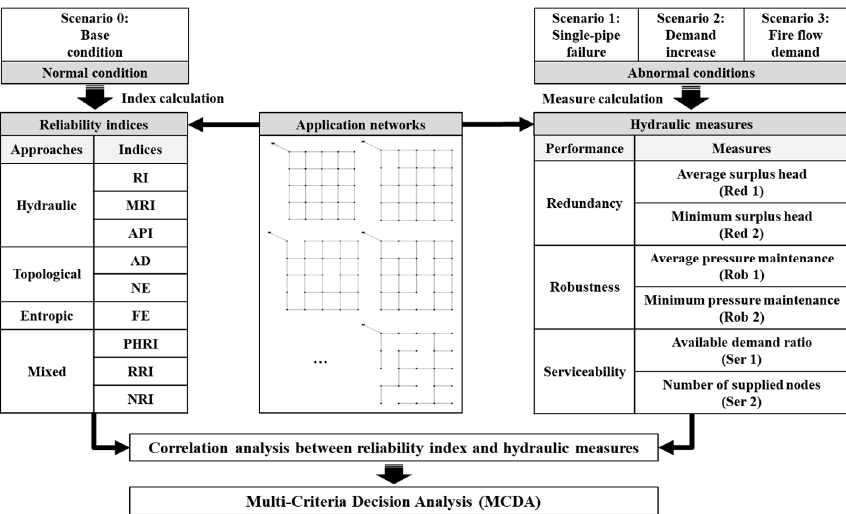
Figure 1. Correlation analysis between reliability indices and hydraulic measures. RI: resilience index, MRI: modified resilience index, API: available power index, AD: average degree, NE: network efficiency, FE: flow entropy, PHRI: pipe hydraulic resilience index, RRI: revised resilience index, NRI: network resilience index.